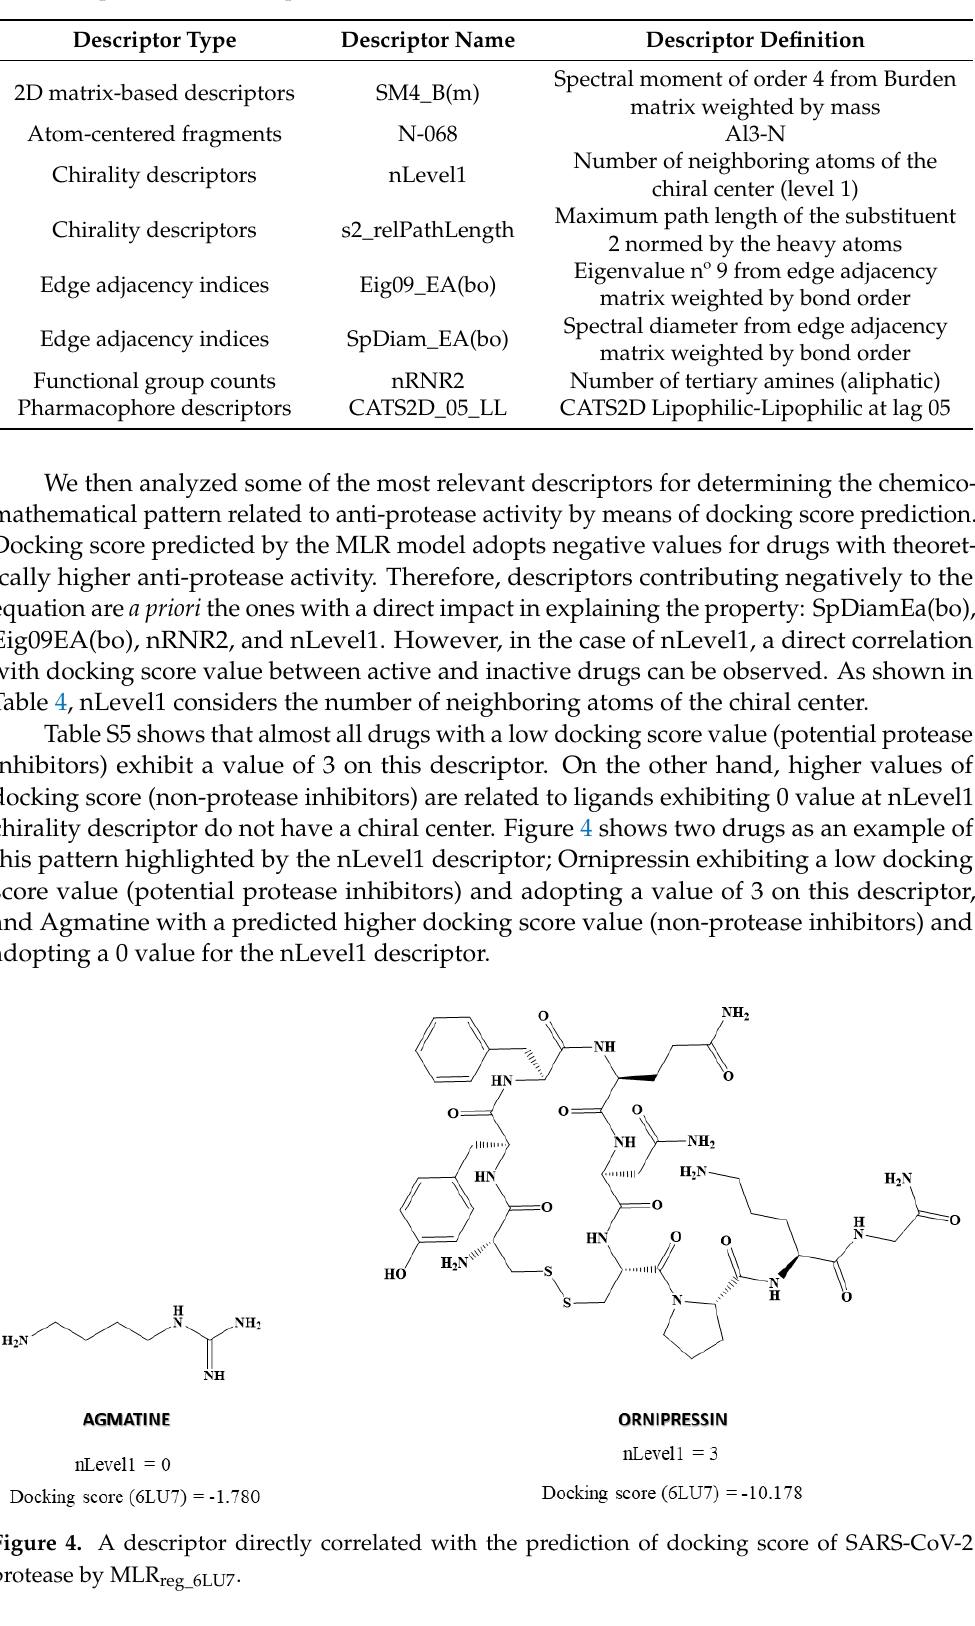
Table 4. Topo-chemical descriptors used in the construction of SARS-CoV-2 models.